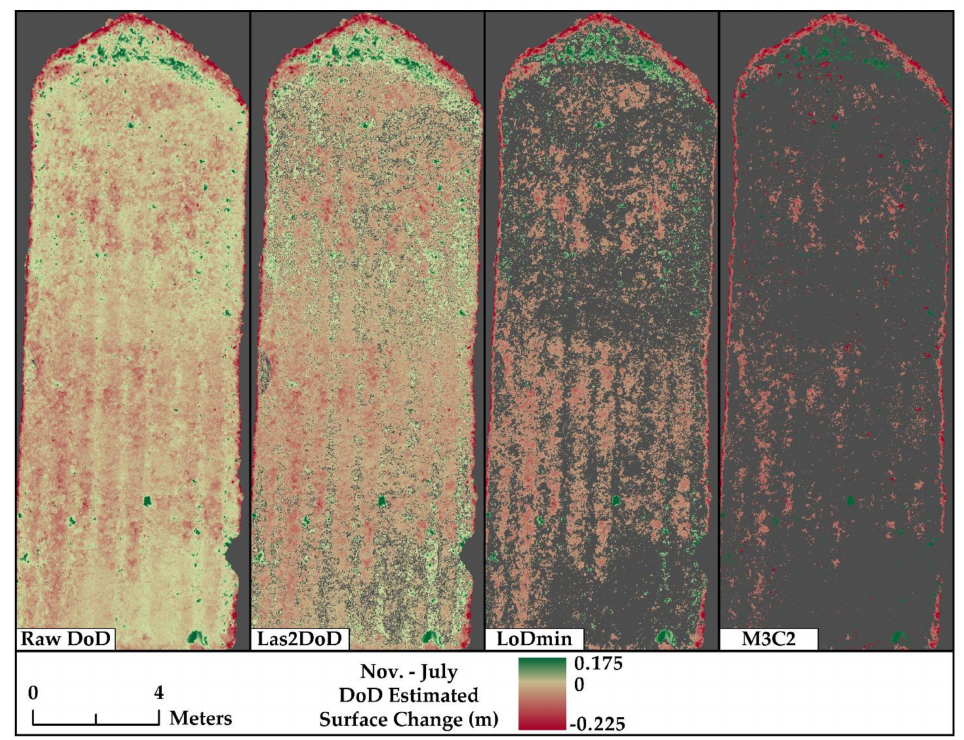
Figure 6. DoD results from Plot B of a DoD without uncertainty analysis and the three tested methods with uncertainty testing.